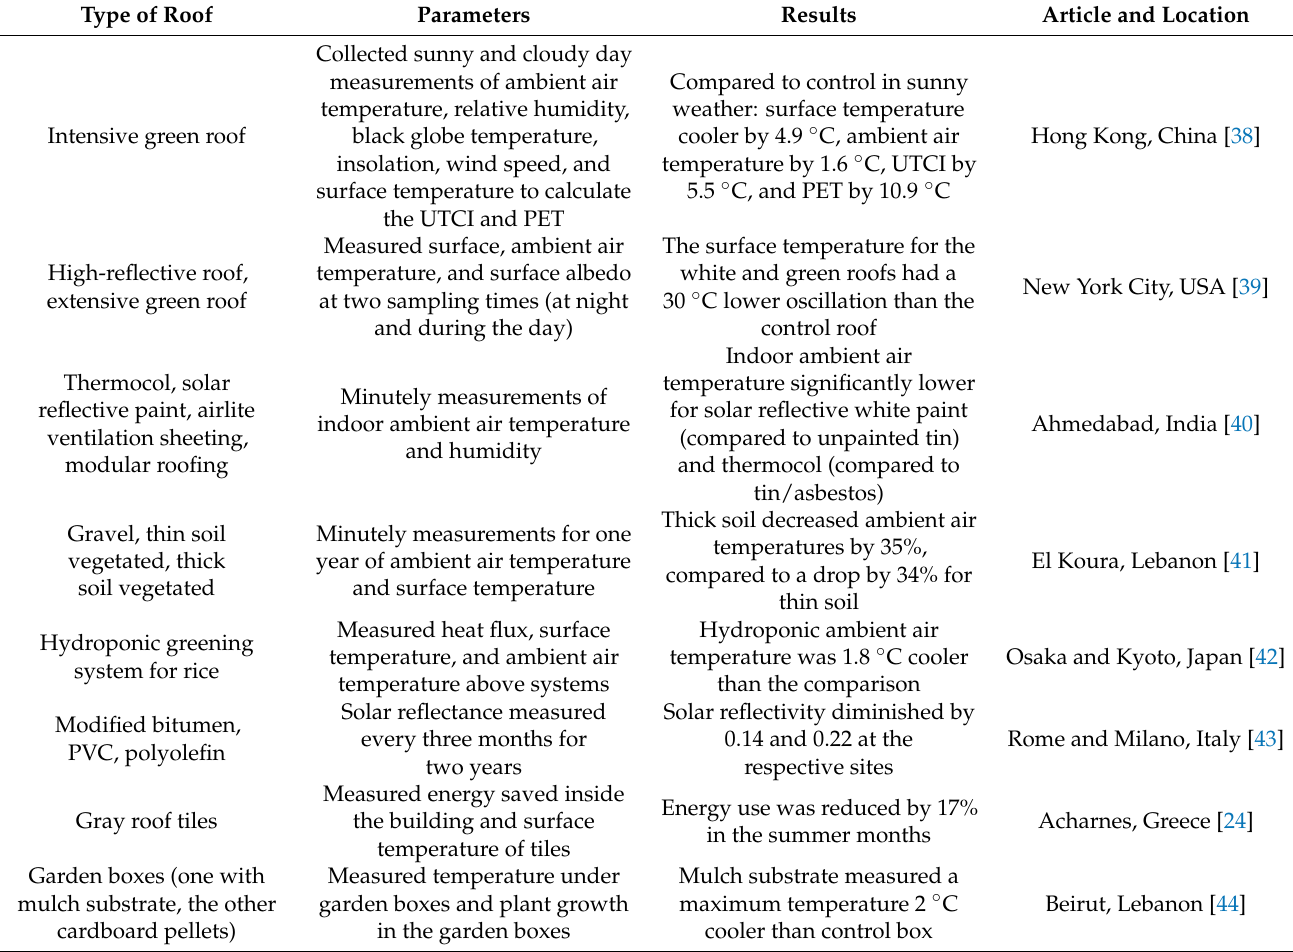
Table 2. Summary of evaluation metrics and results from cool roof intervention